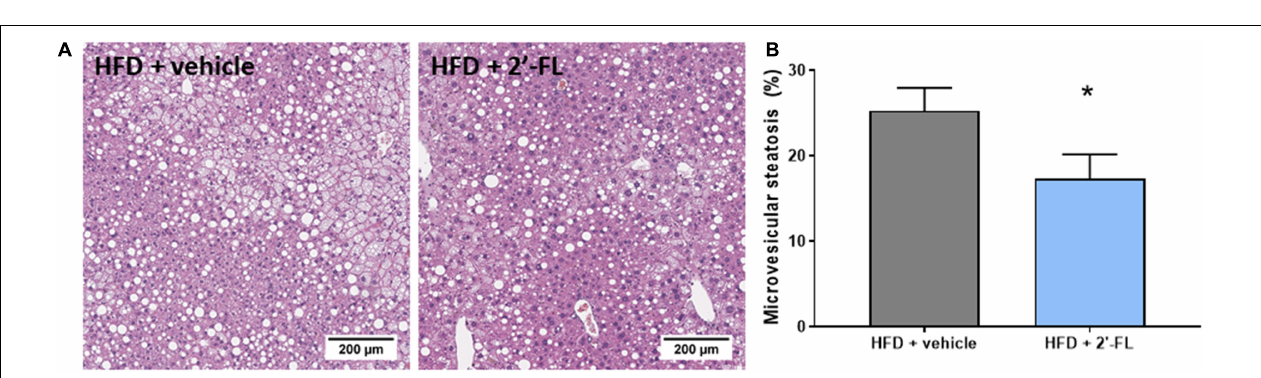
FIGURE 2 | Lipoprotein profiles were analyzed in fasting plasma (pooled from n = 18 mice per treatment group) by fast protein liquid chromatography (FPLC). The plasma is fractionated and lipoprotein particles are collected in the respective fractions. In these fractions, (A) cholesterol and (B) triglyceride concentrations were analyzed and plotted as profiles, which demonstrate changes in lipoprotein particles to which the plasma lipids are associated with.